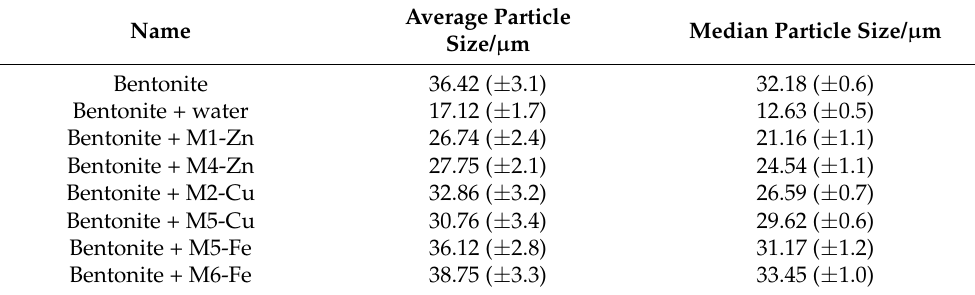
Table 2. Average and median particle sizes of bentonite under different